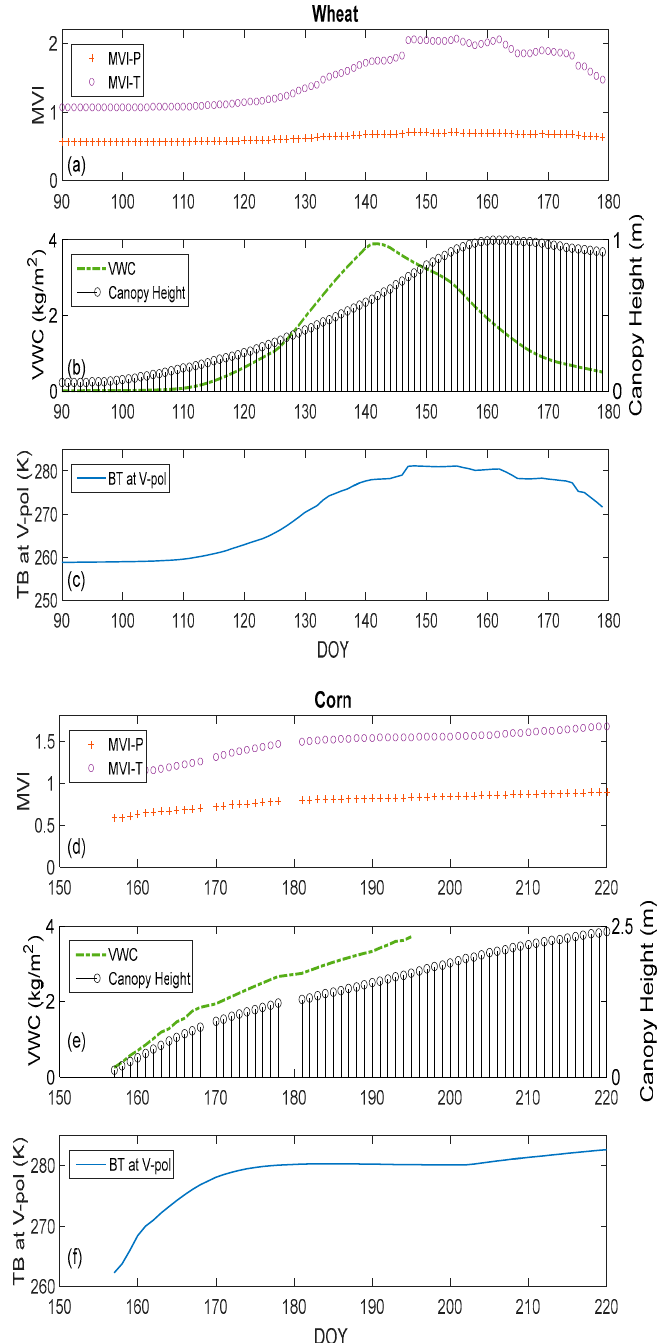
Figure 5. Trends in MVI P and MVI T (V-pol) at 40 ◦ and 50 ◦ incident angle ( a ) wheat and ( d ) corn; vegetation water content and canopy height ( b ) wheat and ( e ) corn; total emissivity ( c ) wheat and ( f ) corn.